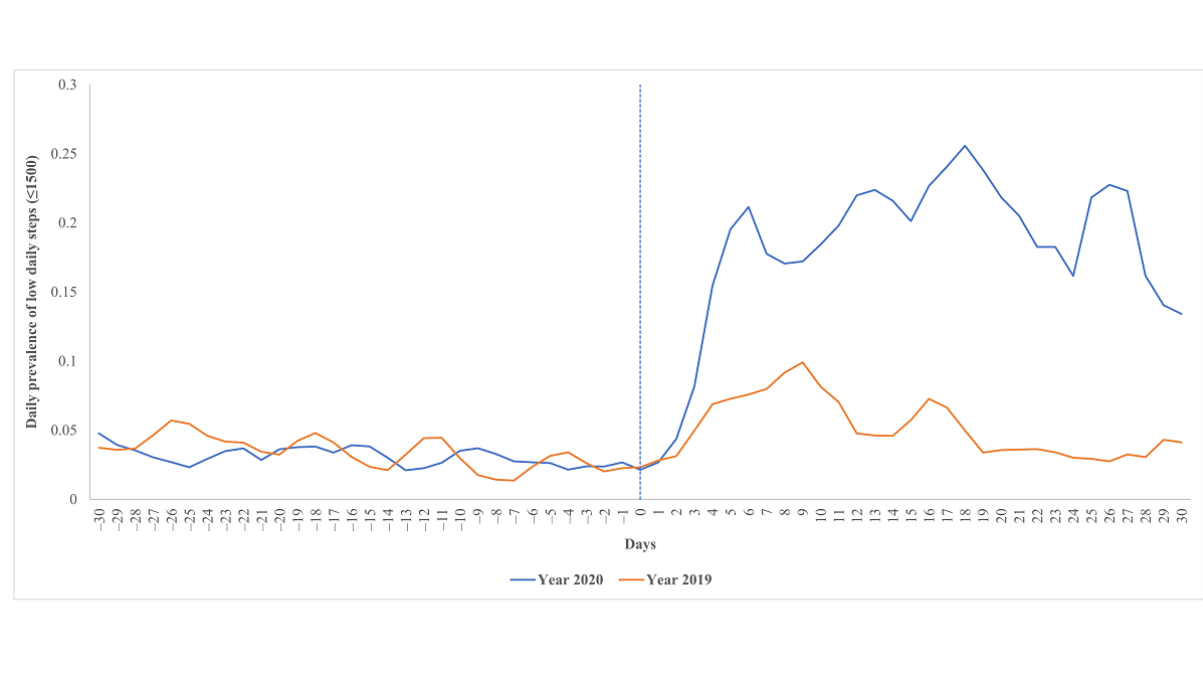
Figure 2. Prevalence of low daily step count ( ≤ 1500 steps/day) around the Chinese Lunar New Year period among participants in 2019 and 2020. Day 0 represents the index date; in 2020, this represents the date of the first COVID-19 case diagnosed in Changsha.